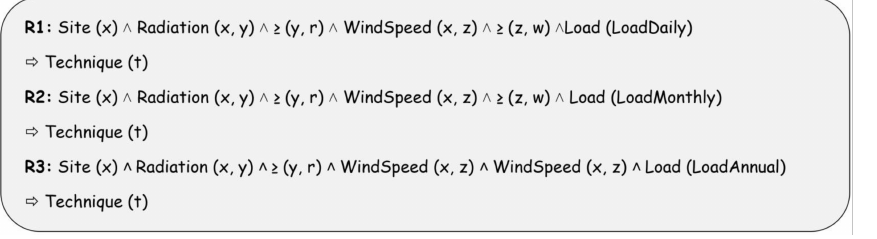
Figure 2. Examples of the solution rules. Table 5. Description of R1, R2, and